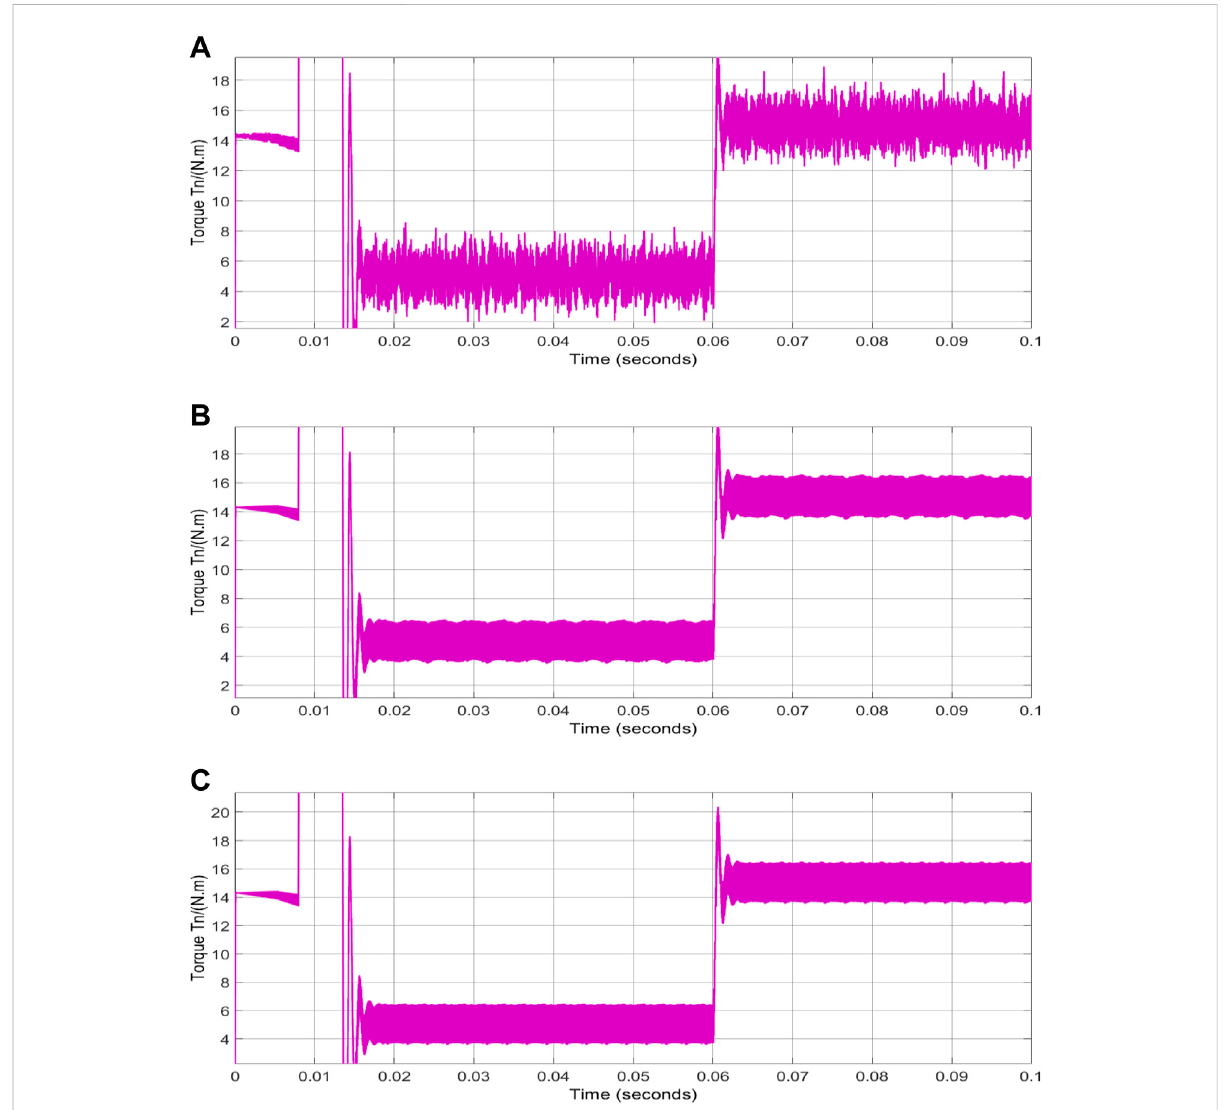
FIGURE 9 (A) Output torque changes of the sensorless motor control system with the SMO based on the sgn function; (B) output torque changes of the sensorless motor control system with the SMO based on the sigmoid function; (C) output torque changes of the sensorless motor control system with the SMO based on the piecewise power